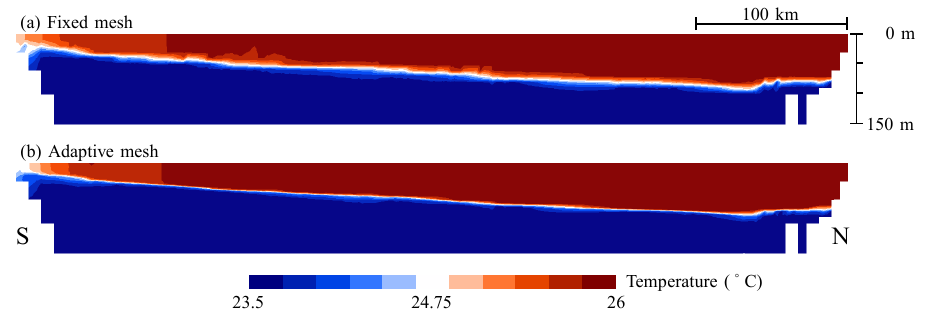
Figure 14. Temperature profile using the uniform wind on 8 July 1993, with the 3-D model, with a fixed mesh (a) and an adaptive mesh (b) having an equal number of elements. The temperature profile is given along the lake main